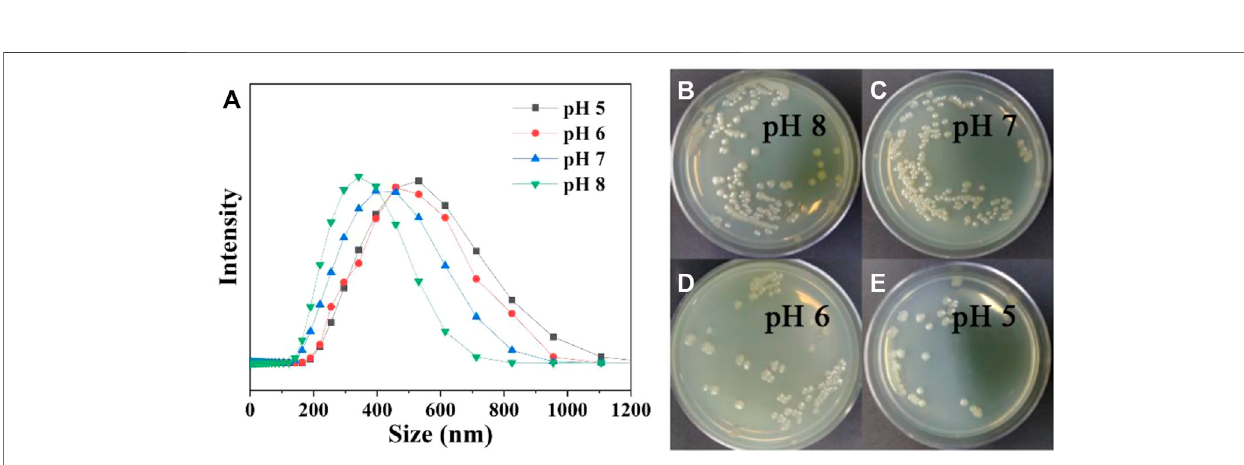
Frontiers in Materials |